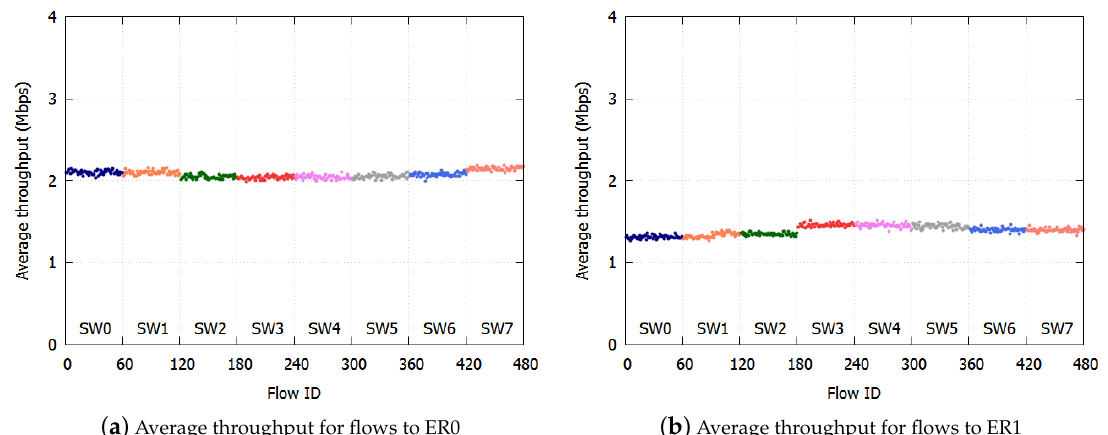
Figure 5. Simulation results with the proposed algorithm. The throughput fairness was realized with high accuracy.